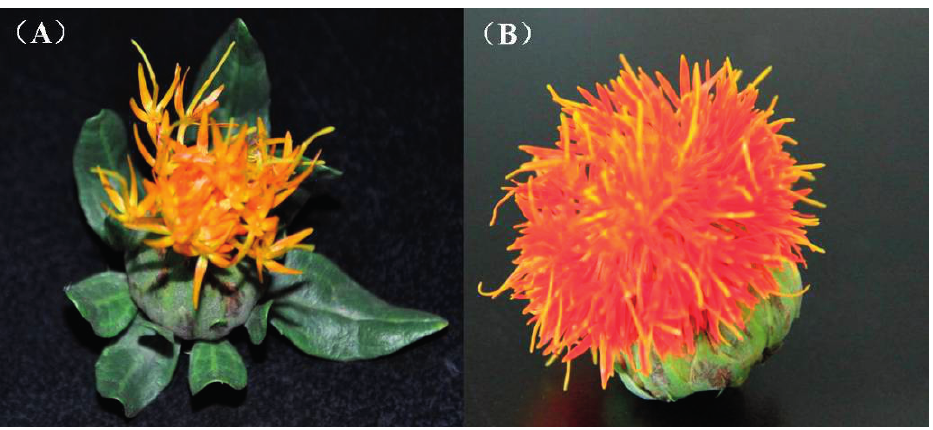
Figure 1. Safflower flower phenotypes in different flowering stages. ( A ) early stage after flowering; and ( B ) full stage after